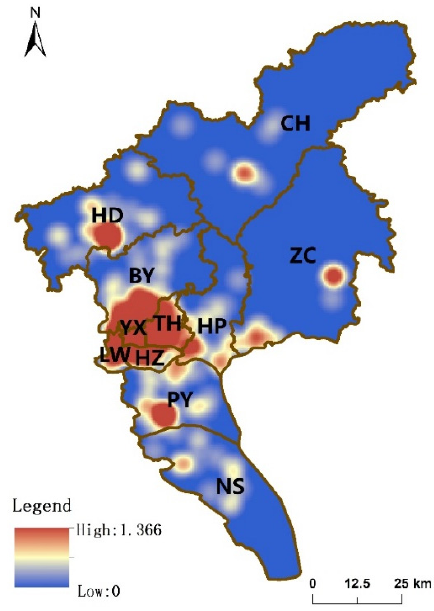
Figure 2. Kernel density map of medical institutions in Guangzhou.